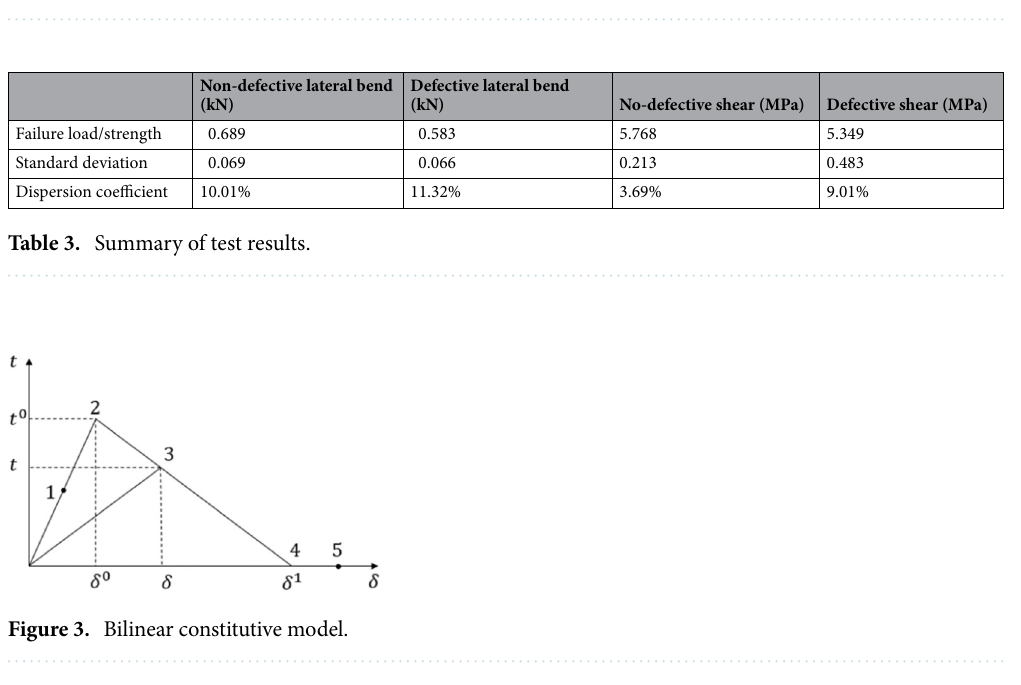
Table 2. Mechanical properties of T1100/5405 and common carbon fiber composites.